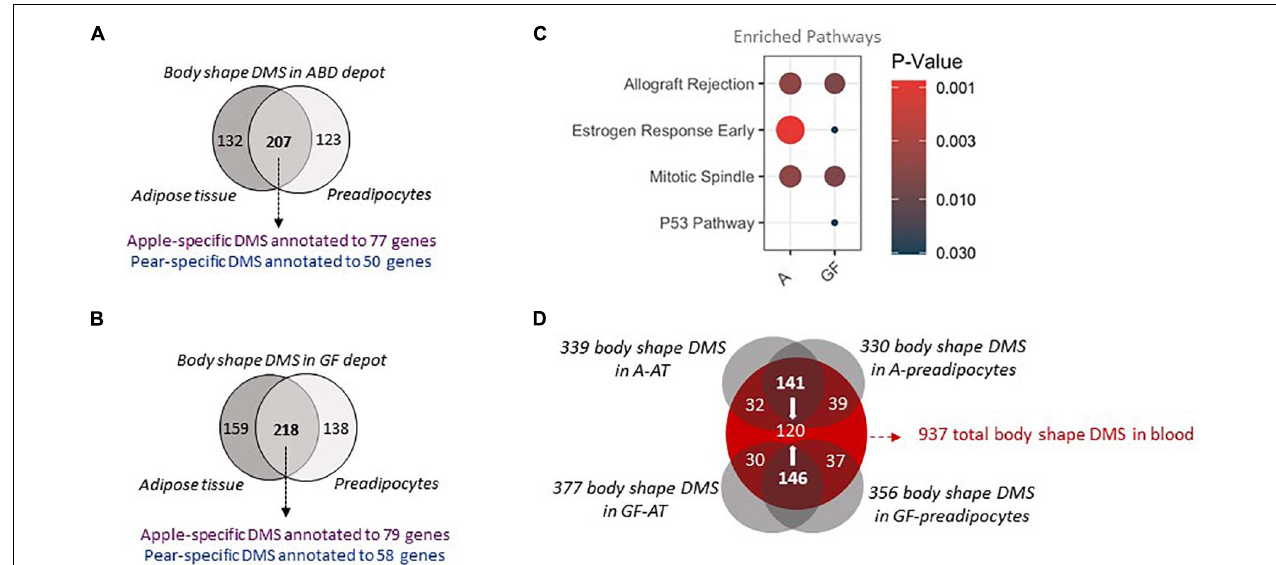
FIGURE 2 | Shared body shape differentially methylated sites between adipose tissue, cultured preadipocytes and whole blood (A,B) . The 2 Venn diagrams depict the differentially methylated sites between 10 apple and 7 pear-shaped subjects in A (A) and GF (B) depot only in adipose tissue, only in preadipocytes or in both. Purple color depicts the number of unique genes annotated to sites hypermethylated in apple-shaped women. Blue color depicts the number of unique genes annotated to sites hypermethylated in pear-shaped women. (C) Pathway Analysis of the genes nearest the body shape specific DMS in A depot (A) and GF depot (GF). Only the common genes between whole tissue and cells were used. The size of the dots represents gene count. Only pathways with p -value < 0.05 are represented. (D) The Venn diagram depicts the common body shape DMS between adipose tissue, preadipocytes and blood for the 17 subjects. A = Abdominal, GF = Gluteo-femoral, DMS = Differentially Methylated